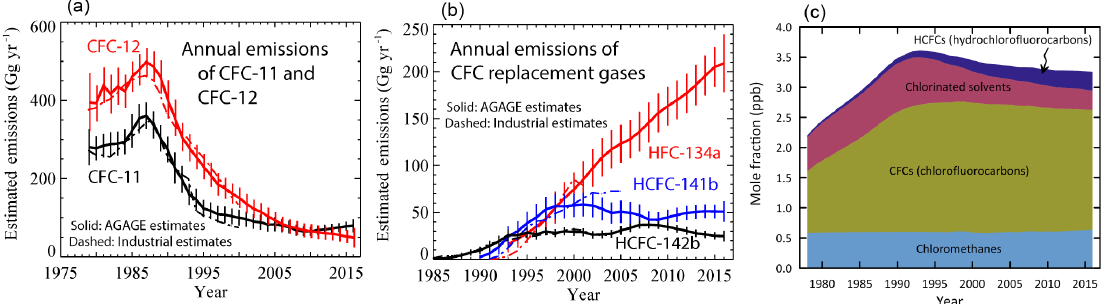
Figure 4. Inversely estimated emissions using our Bayesian statistical approach (Sect. 3.3) and our 12-box model (Sect. 3.7) of the fol- lowing: selected AGAGE regulated gases (a) and selected AGAGE replacement gase (b) compared to estimates from industrial, national, and/or UNEP reports. Estimates of total tropospheric chlorine from all AGAGE data ( c ; chlorinated solvents are CCl 4 and CH 3 CCl 3 ; chloromethanes are CH 3 Cl, CH 2 Cl 2 , and CHCl 3 ; see Table 1 for a full list of AGAGE chlorine-containing